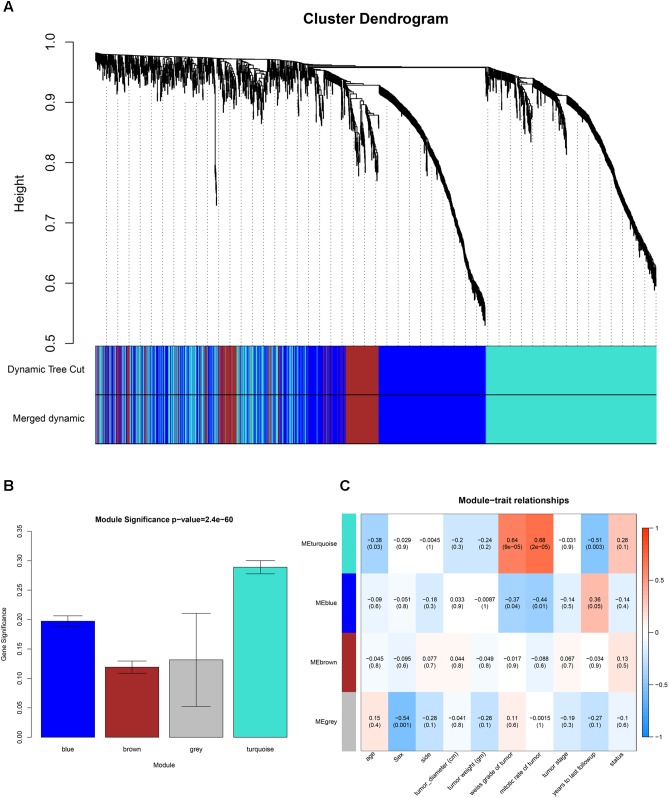
Identification of modules associated with clinical information. (A) Dendrogram of all differentially expressed genes clustered based on a dissimilarity measure (1-TOM). (B) Heatmap of the correlation between module eigengenes (MEs) and different clinical information of ACC (age, gender, side, tumor diameter (cm), tumor weight (gm), weiss grade of tumor, mitotic rate of tumor, tumor stage, years to last follow-up and status). (C) Distribution of average gene significances and errors in the modules associated with the weiss grade of ACC.